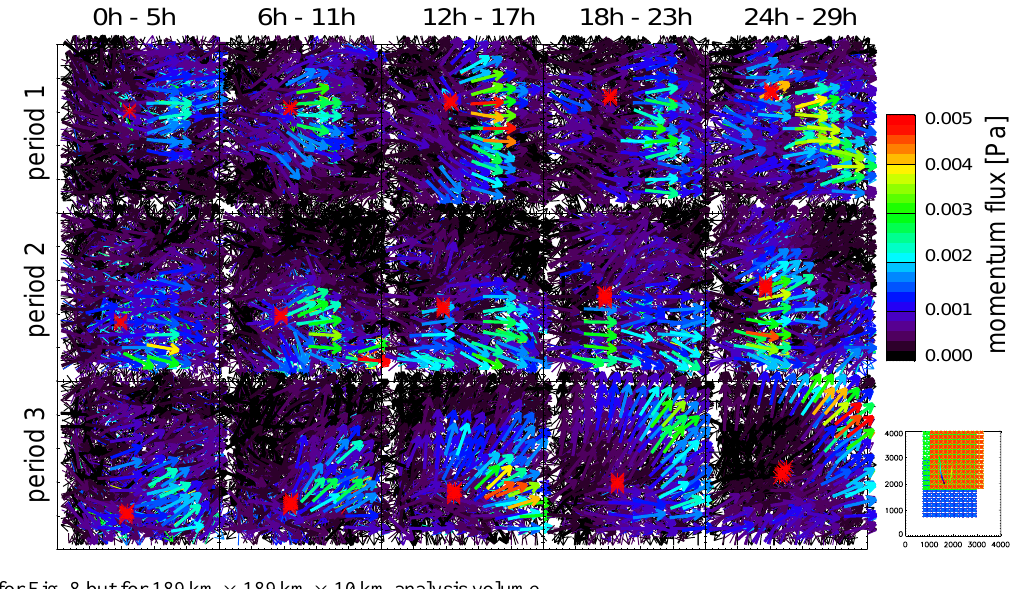
Fig. 10. As for Fig. 8 but for 189km × 189km × 10km analysis volume.